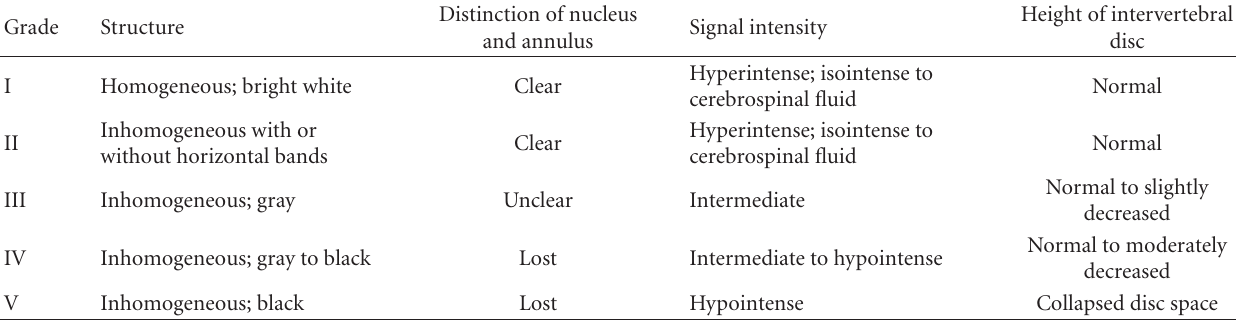
Table 1: Table lists the classification of levels of disc degeneration. Adapted from Pfirrmann et al.